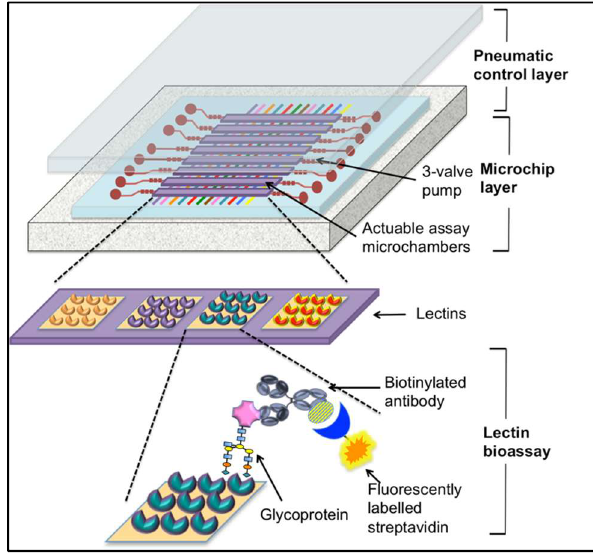
Figure 4. Multi-channel microfluidic lectin-based barcode bioassay. This schematic is a representation of an antibody-lectin sandwich assay on a microfluidic chip. It contains parallel units that have a three-valve pump that promotes fluidic mixing in the assay chamber. Glycoproteins are captured by lectins and detected with biotinylated antibodies against the targeted glycoproteins, which are subsequently identified using fluorescently labelled streptavidin. (Image adapted from Shang et al., 2016).